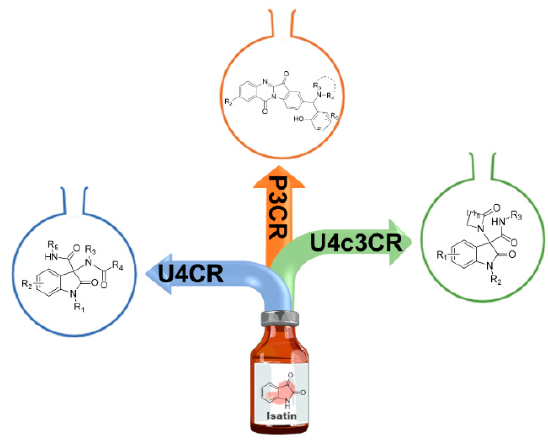
Figure 1. Isatin as a starting point for Figure 11. Isatin as a starting point for MCRs.